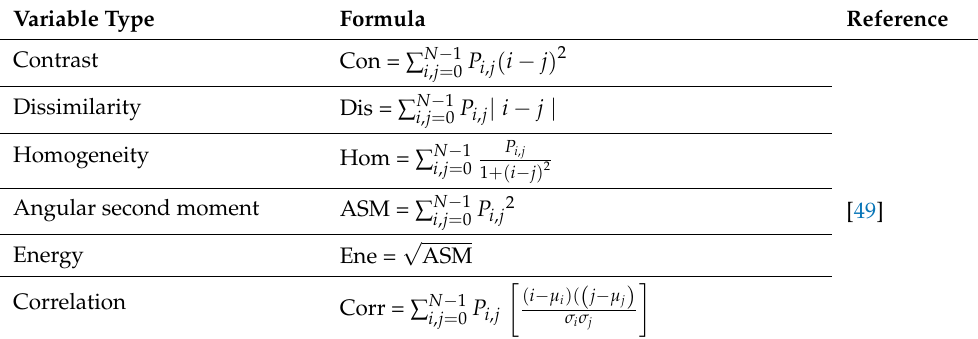
Table 3. Description of the GLCMF derived from digital images. Variable Type